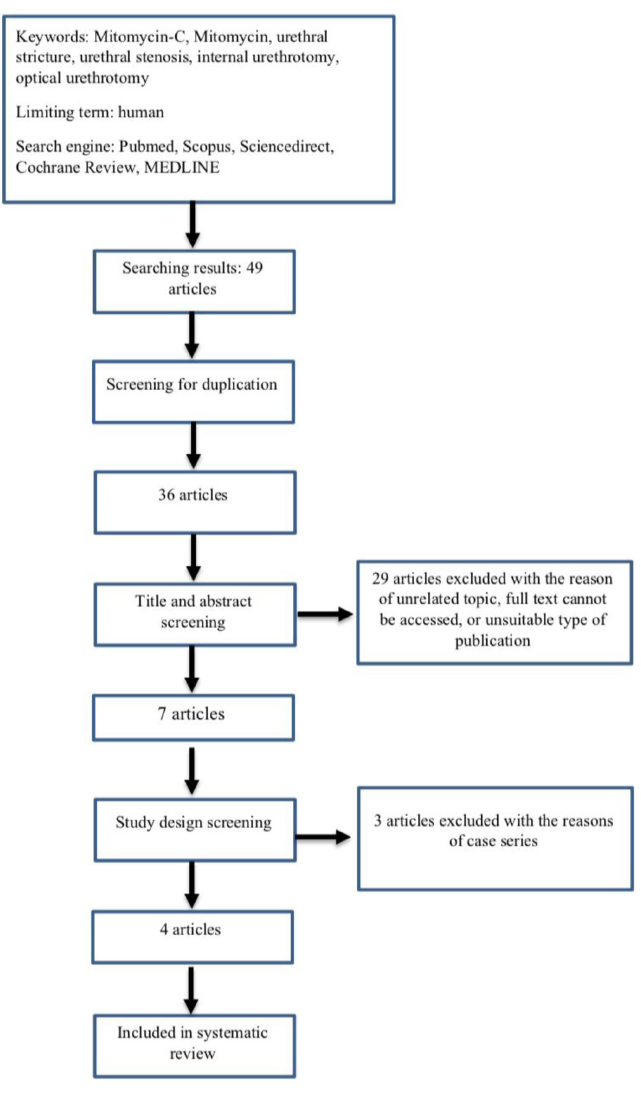
Figure 1. Study flow